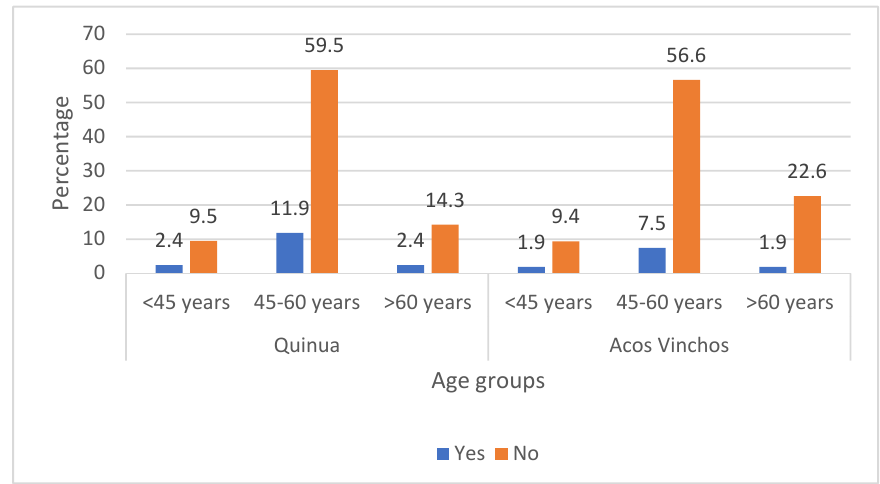
Figure 2. Response to the use of quinoa and/or cañihua plants as medicinal plant according to age groups.